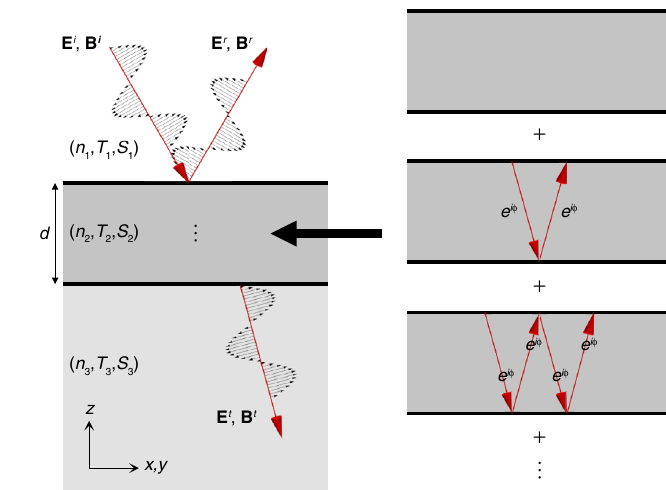
Fig. 3 | Re fl ections by PT -symmetric magneto-electric media. We assume PT symmetry to exclude natural optical activity, for simplicity. a Single interface. The light propagation within each medium is determined by the refractive index n and origin-independent magneto-electric coupling T ij and electric quadrupole sus- ceptibility S ijk tensors. We consider the case where no birefringence occurs such